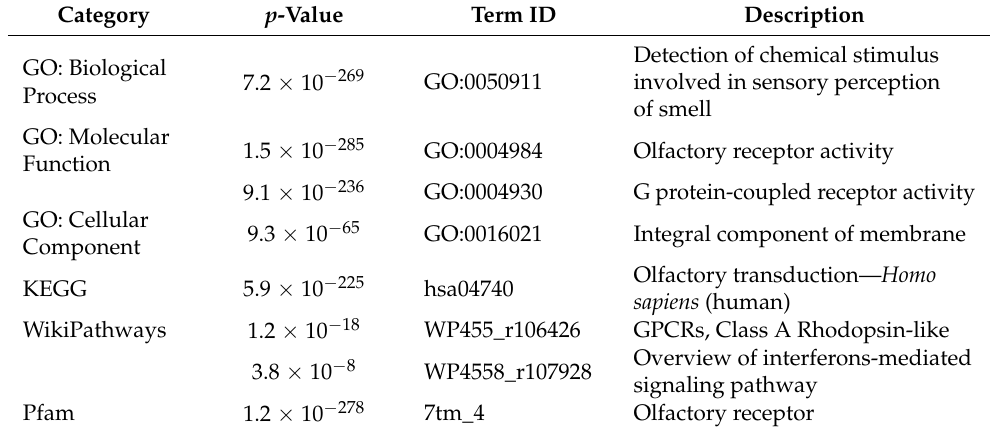
Table 11. Selected top gene term enrichments of the coexpressed genes to OR1D2 in HGCA2.0. Category p -Value Term